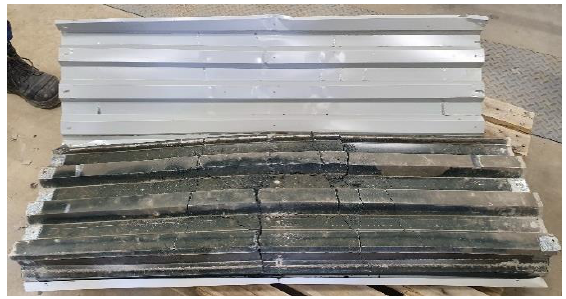
Figure 7. Load vs. displacement of triple-cell infill panels. Table 5. Results from triple-cell infill panels.